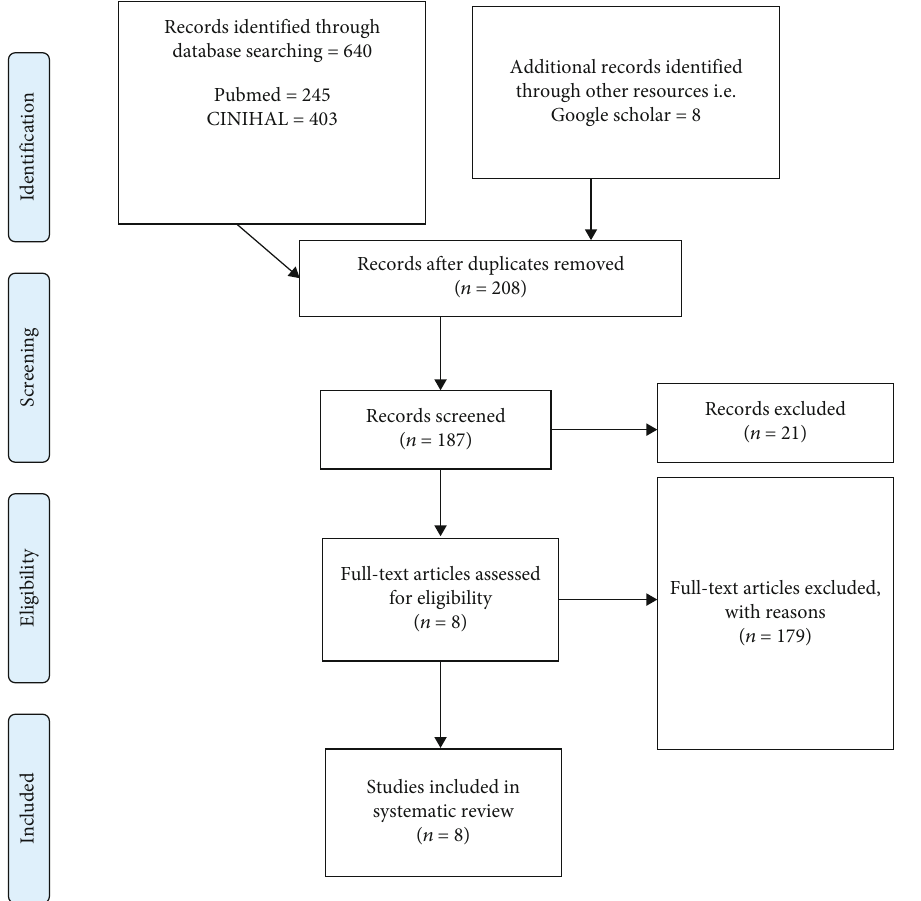
Figure 1: PRISMA fl ow chart showing the search process.